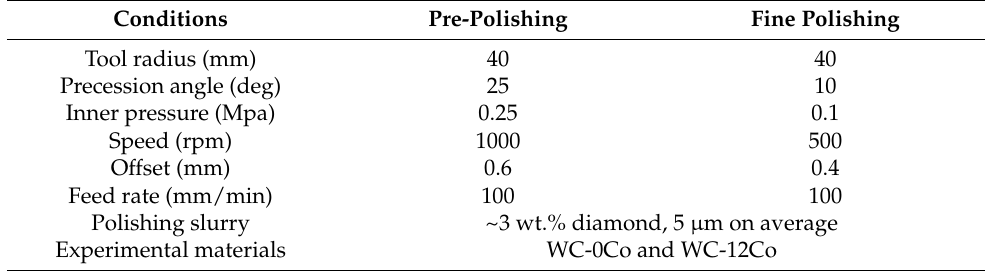
Table 2. Uniform removal